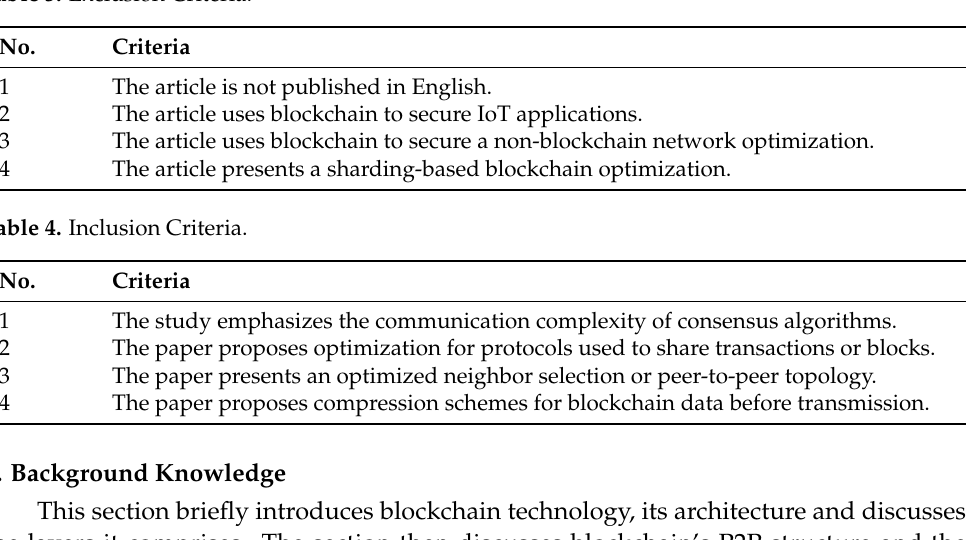
Table 3. Exclusion Criteria.